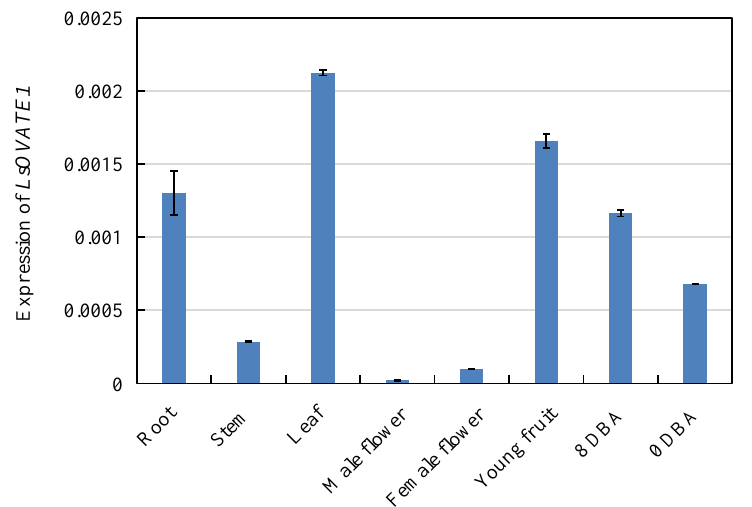
Figure 6. LsOVATE1 expression levels in different organs and growth stages, including expression of LsOVATE1 in roots, stems, leaves, male flowers, female flowers, young fruits, and ovaries at 8 days before anthesis (8 DBA) and 0 days before anthesis (0 DBA) from HZ plants. Values are means ± SD of three replicates.